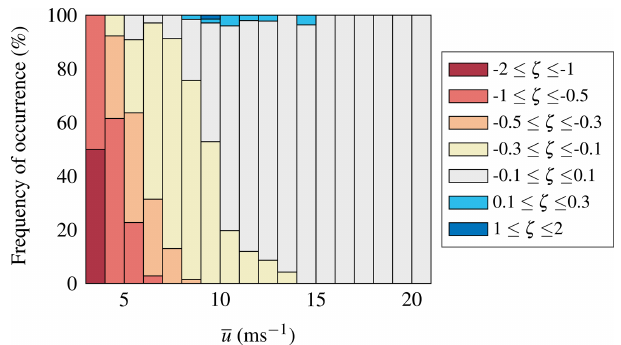
Figure 10. Histogram of the dimensionless stability parameter ζ us- ing 50min long records from February 2019 to March 2020, com- puted using the scanning lidars and the HATPRO radiometer.